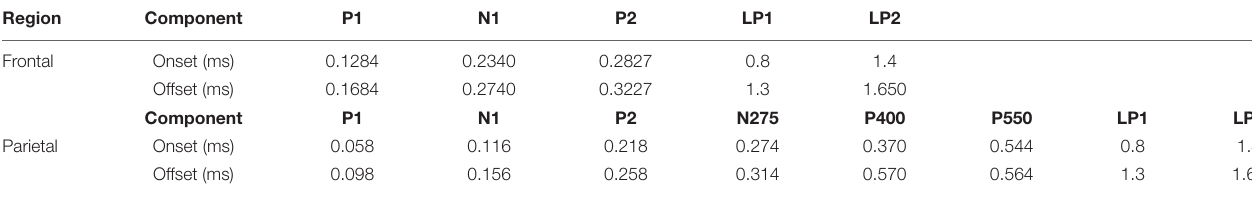
FIGURE 2 | Attentional bias task stimulus configuration showing two consecutive trials and EEG epoch.